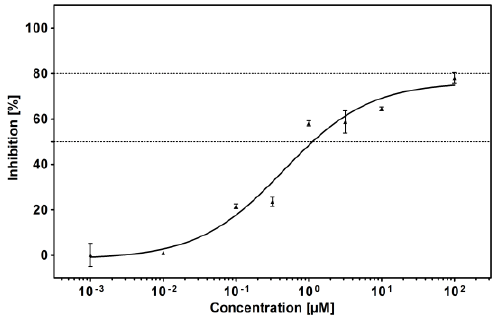
Figure 6. Determination of the IC 50 value towards recombinant human CK2 of bikaverin (6,11-dihydroxy-3,8-dimethoxy-1-methylbenzo[ b ]xanthene-7,10,12-trione), the hit compound identified by ZINC database mining.CK2 holoenzyme was pre-incubated with different bikaverin concentrations (0.001–100 μM) and subsequently the in vitrophosphorylation of CK2 specificsubstrate peptide was determined by CE [30]. Relative CK2 activity at each inhibitor concentration is given in a dose-response diagram. IC 50 values were determined in three independent replications and mean values with corresponding standard deviations are given.